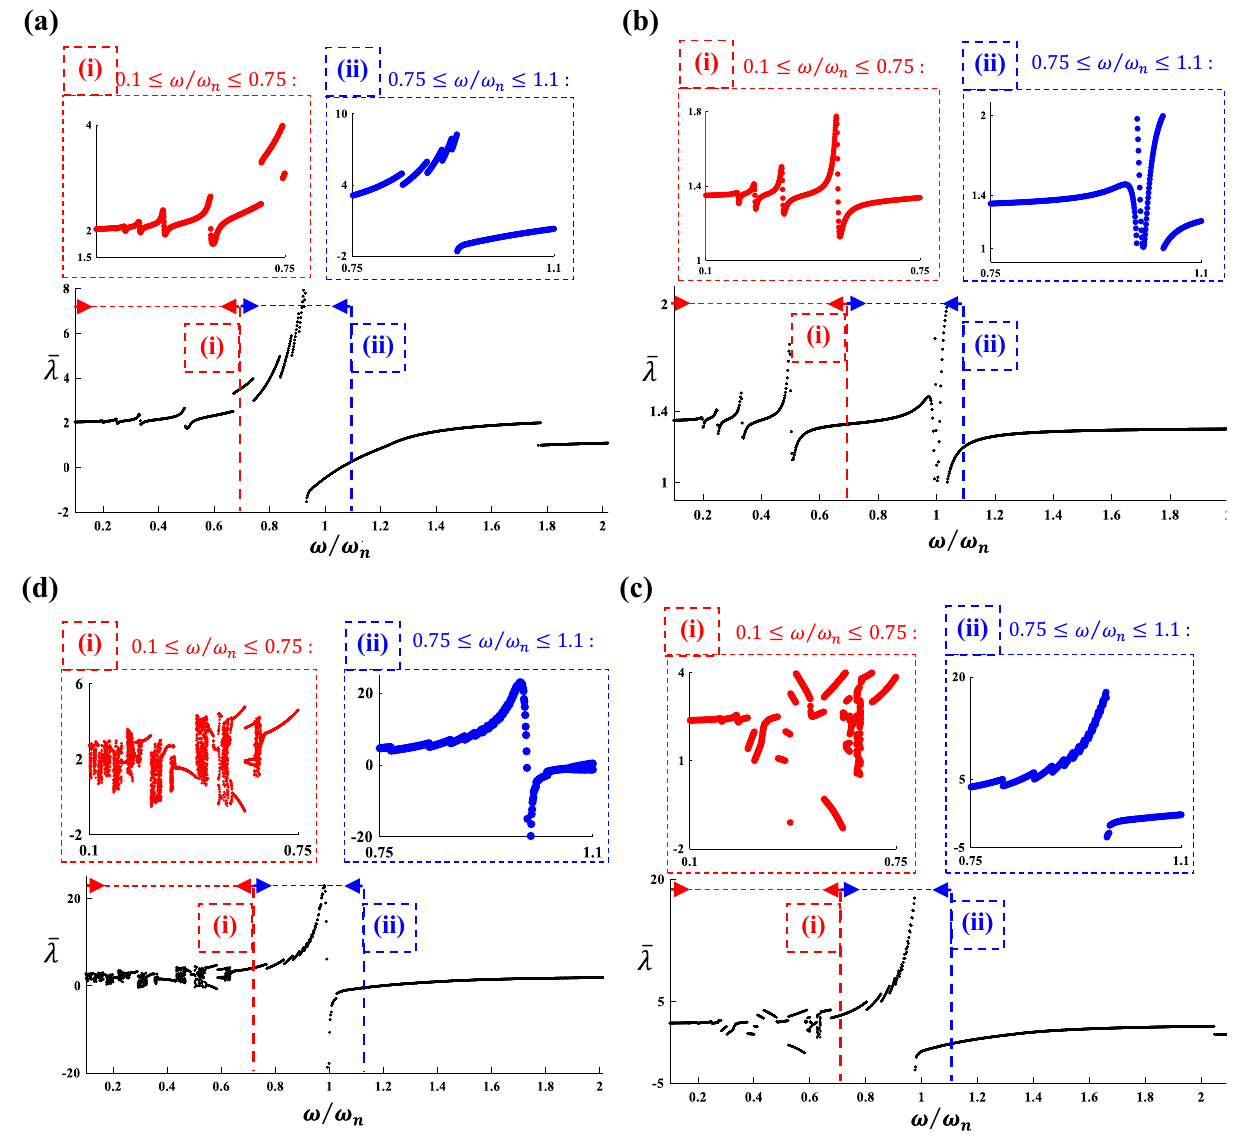
Fig. 5 Bifurcation diagram, a n f = 0 , b n f = 0.5 , c n f = 0.75 , and d n f =